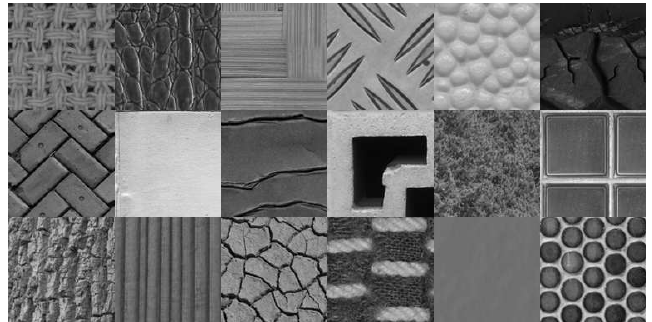
Figure 2. Samples of the 18 categories randomly selected from the CGT